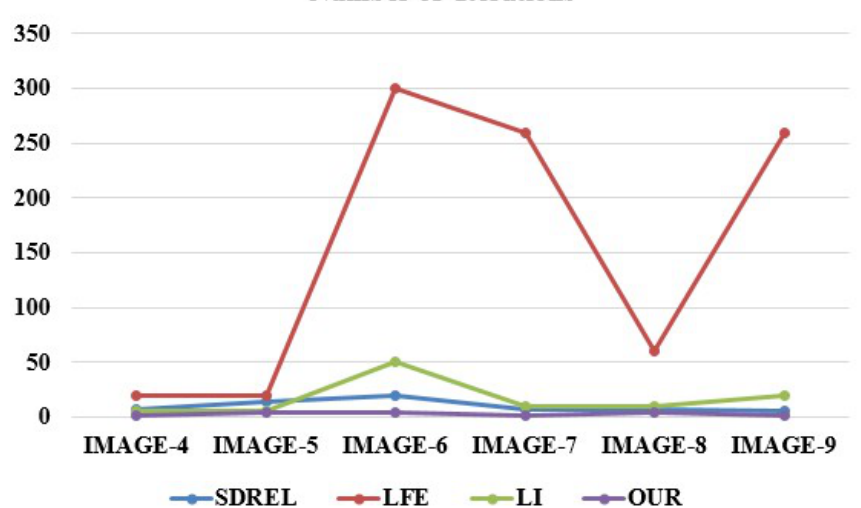
Figure 8. Comparison of our algorithm with three methods on the basis of the number of iterations.